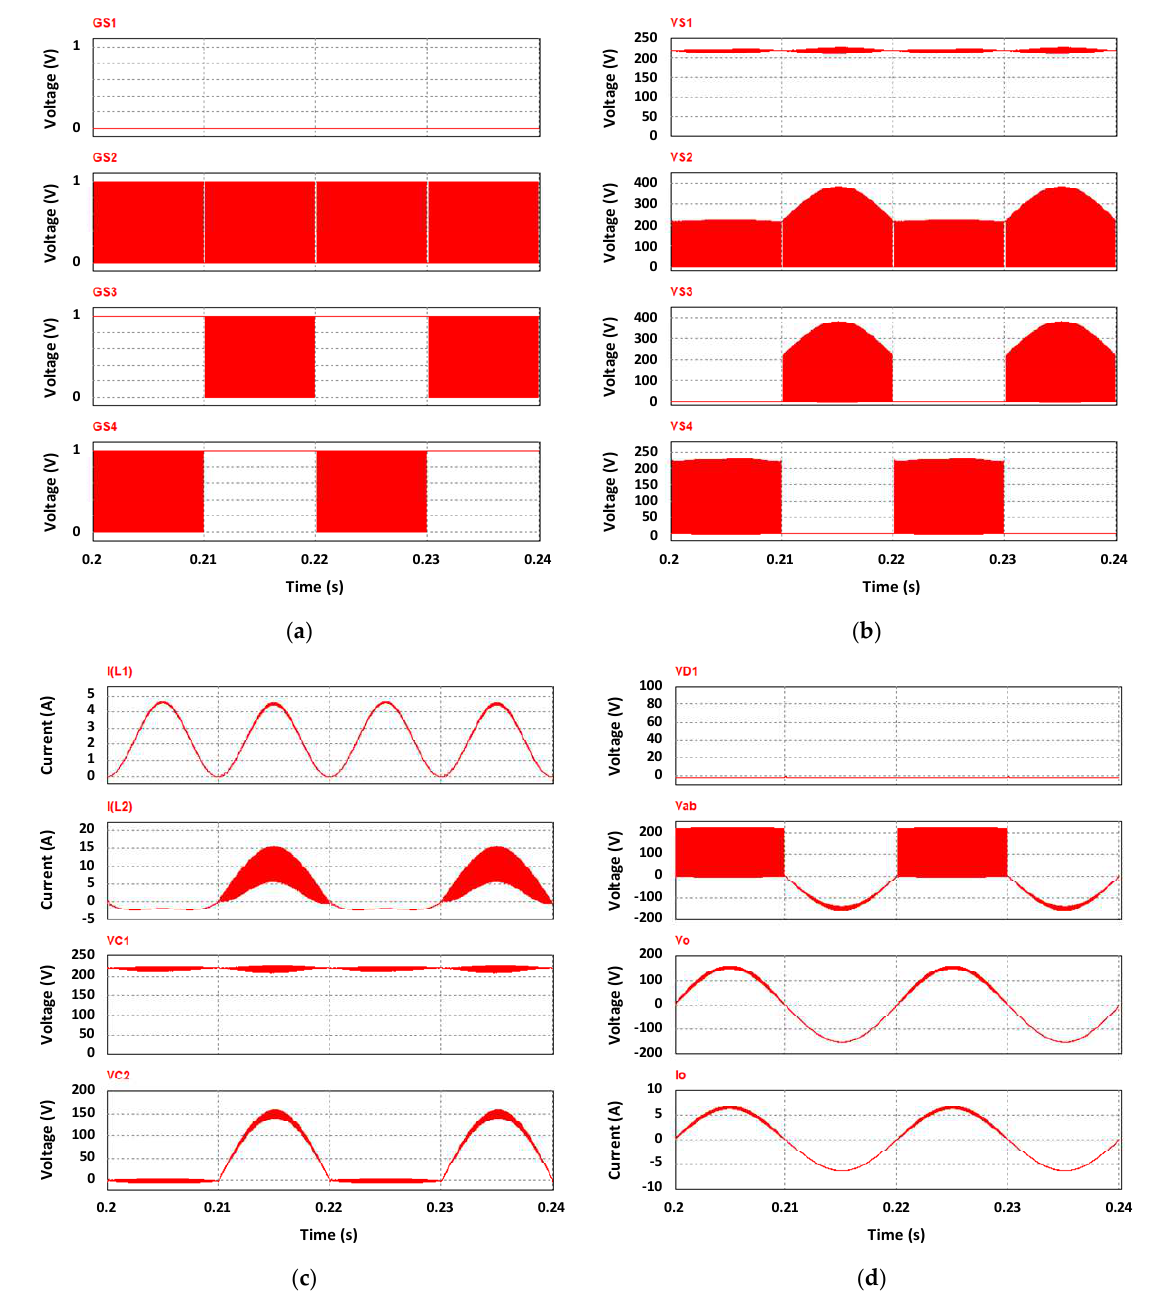
Figure 6. Simulation results for the proposed single-stage BB-BTI when V in = 220 V. ( a ) Control signals of S 1 , S 2 , S 3 , and S 4 . ( b ) Voltages V S 1 , V S 2 , V S 3 , and V S 4 . ( c ) currents i L 1 , i L 2 , and voltages v C 1 , v C 2 . ( d ) Voltages V D 1 , v ab , and v o , and current i o .